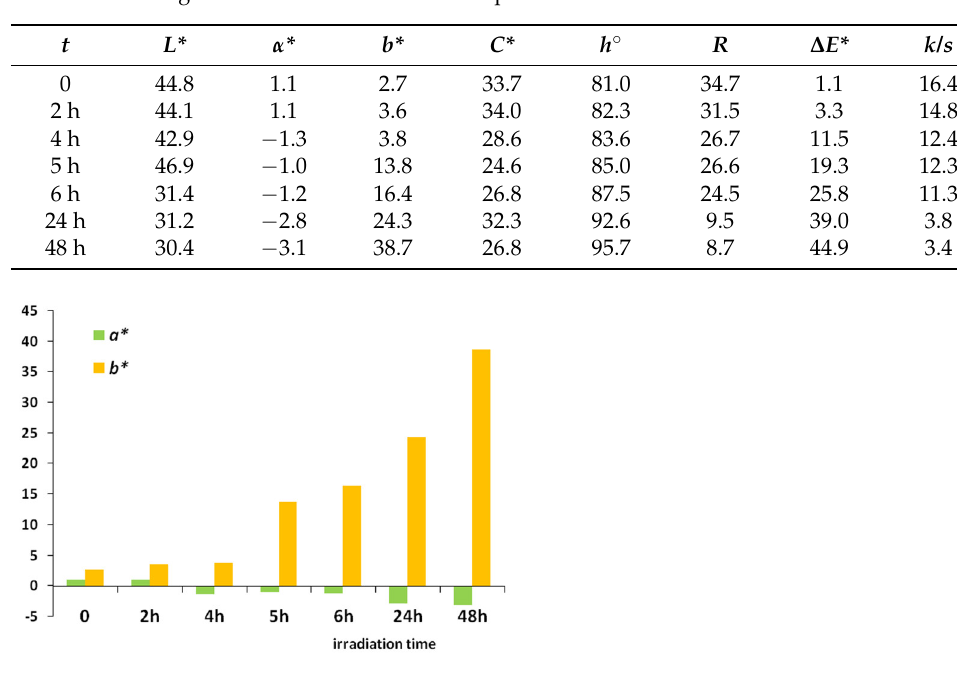
Figure 6. Plot of a* and b* coordinates over the irradiation time in UV. Figure 6. Plot of a * and b * coordinates over the irradiation time in